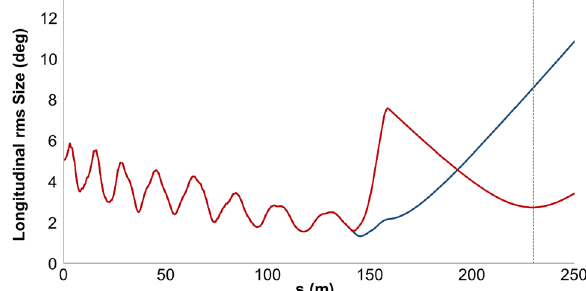
TABLE I. Ion beam design parameters at the IP.